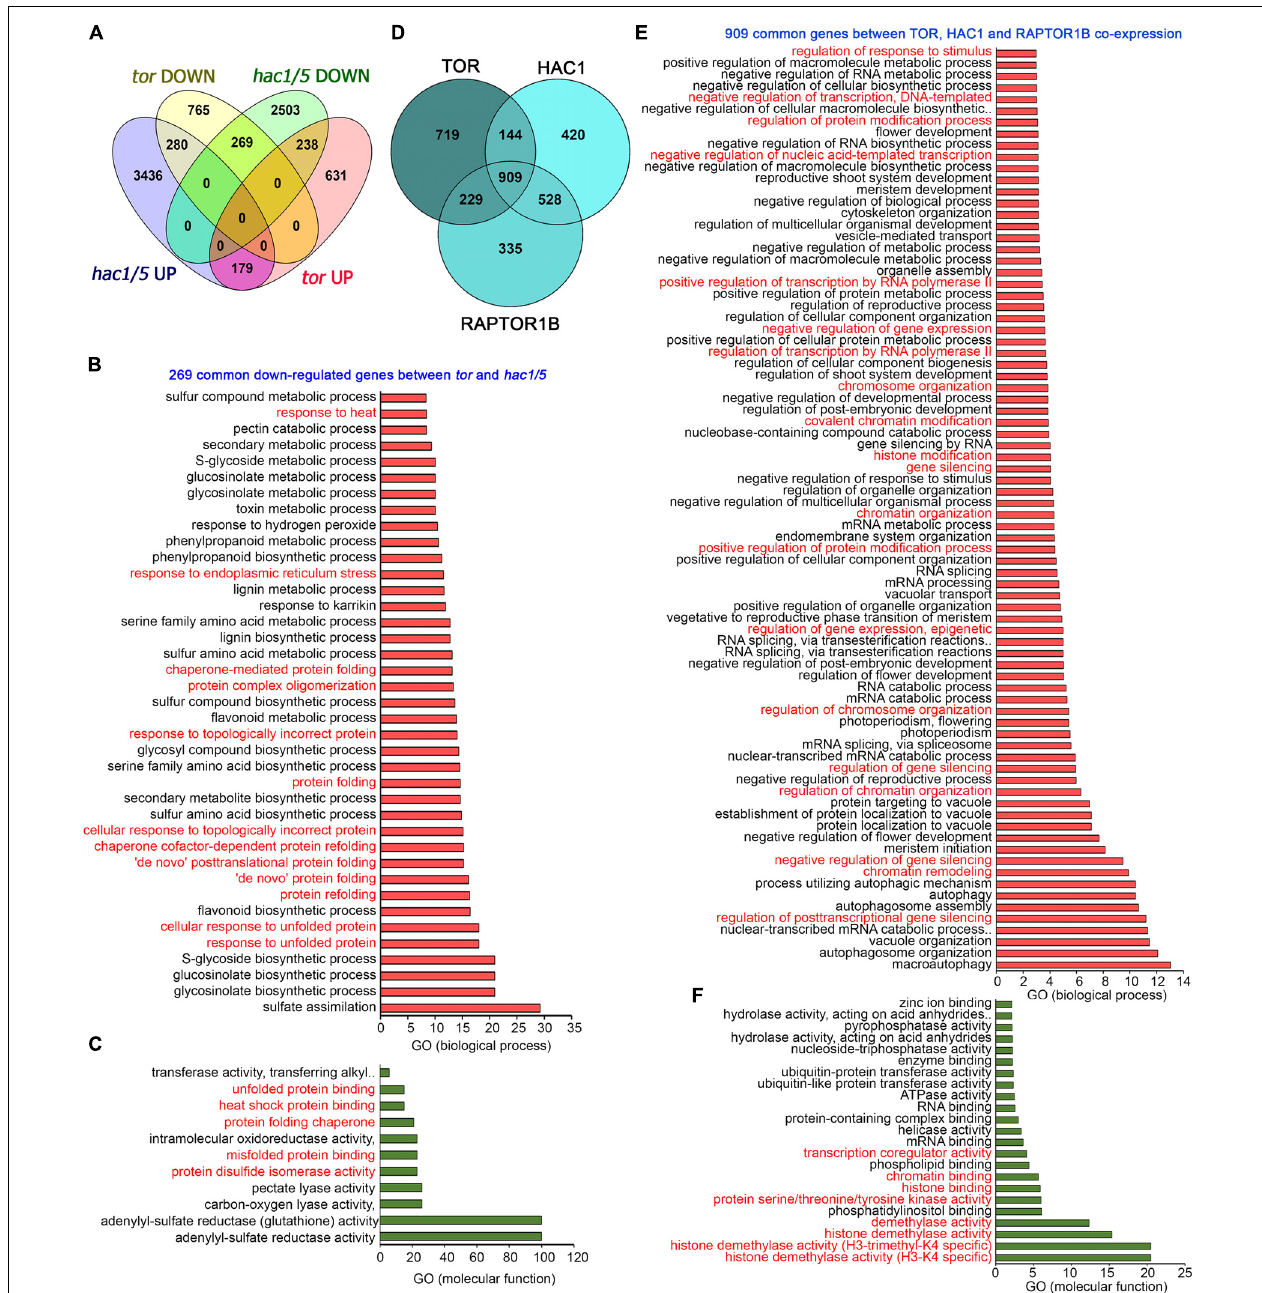
FIGURE 8 | Transcriptome comparison of TOR microarray with differentially expressed genes in hac1 . (A) A Venn diagram showing overlap of genes differentially expressed in tor and hac1/5 mutants. Transcriptome data of TOR and HAC1 were obtained from public resources (Xiong et al., 2013; Jin et al., 2018). Genes in hac1/5 mutants were extracted based on their false discovery rate value less than.05. (B,C) The GO biological process and molecular function of 269 genes commonly downregulated by tor and hac1/5 . (D) A Venn diagram showing overlap of co-expression genes between TOR, HAC1, and RAPTOR1B. Co-expression genes were extracted from the ATTED-II database, and a total of 2,000 genes were used for co-expression genes overlap. (E) The GO biological process of 909 commonly co-expressed genes between TOR, HAC1, and RAPTOR1B. (F) GO molecular function of 909 commonly co-expressed genes between TOR, HAC1, and RAPTOR1B. Panther 15.0 tool was used to analyse GO-fold enrichment using Bonferroni correction and Fisher’s exact test type.